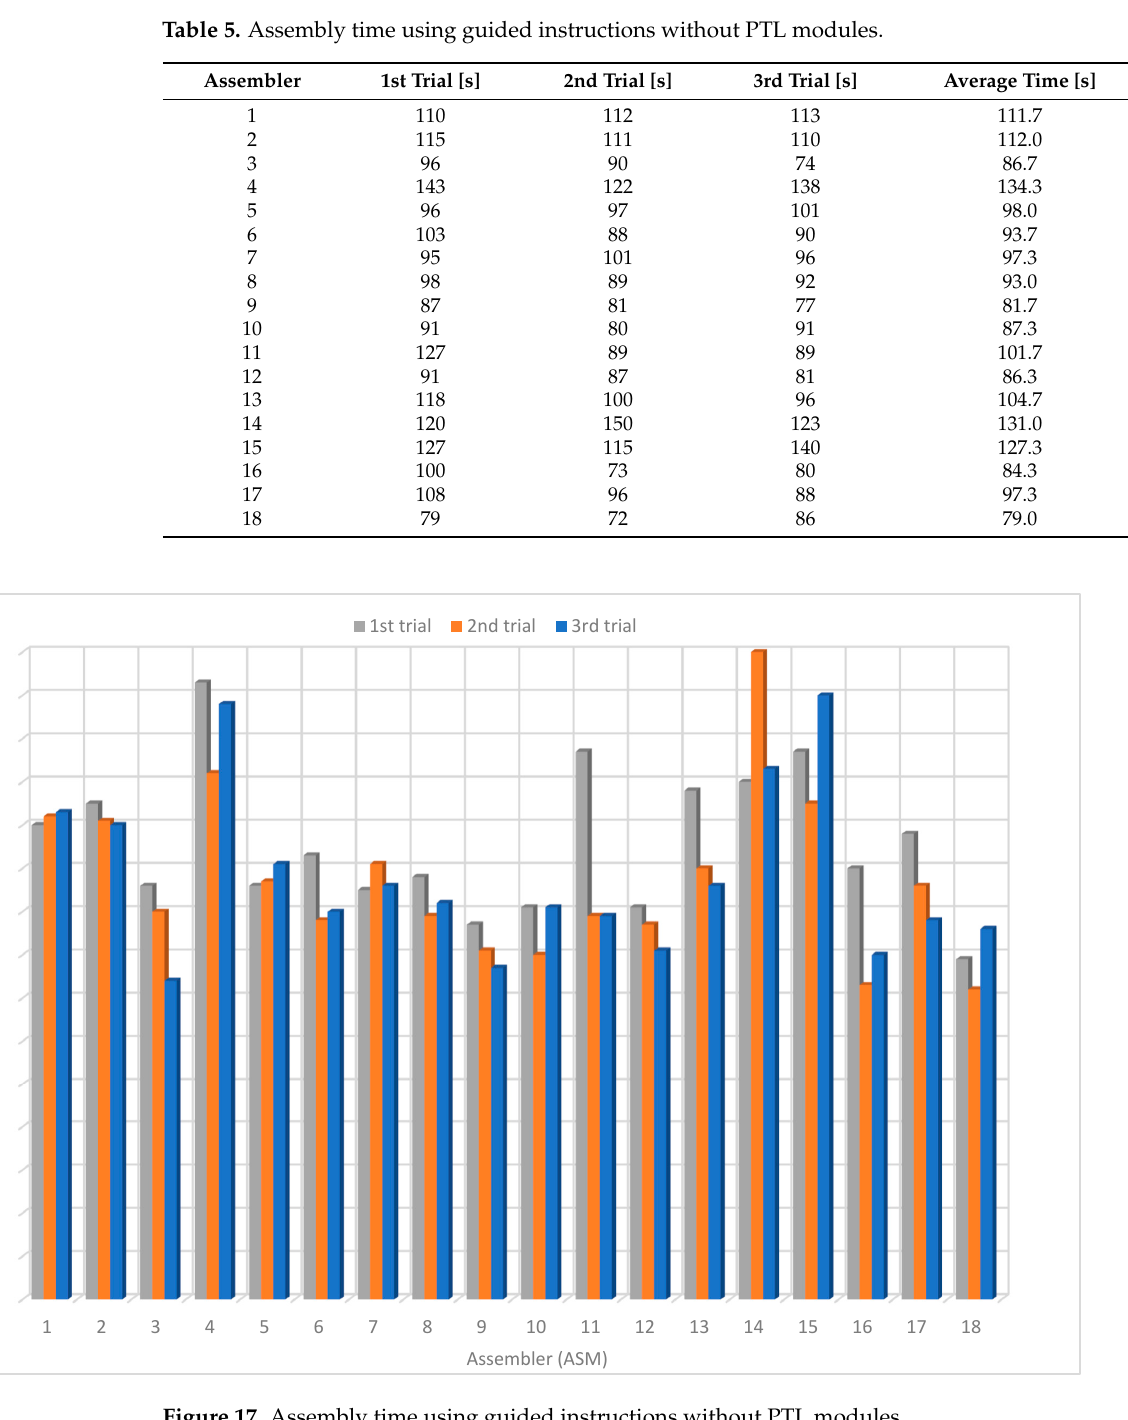
Figure 17. Assembly time using guided instructions without PTL modules.